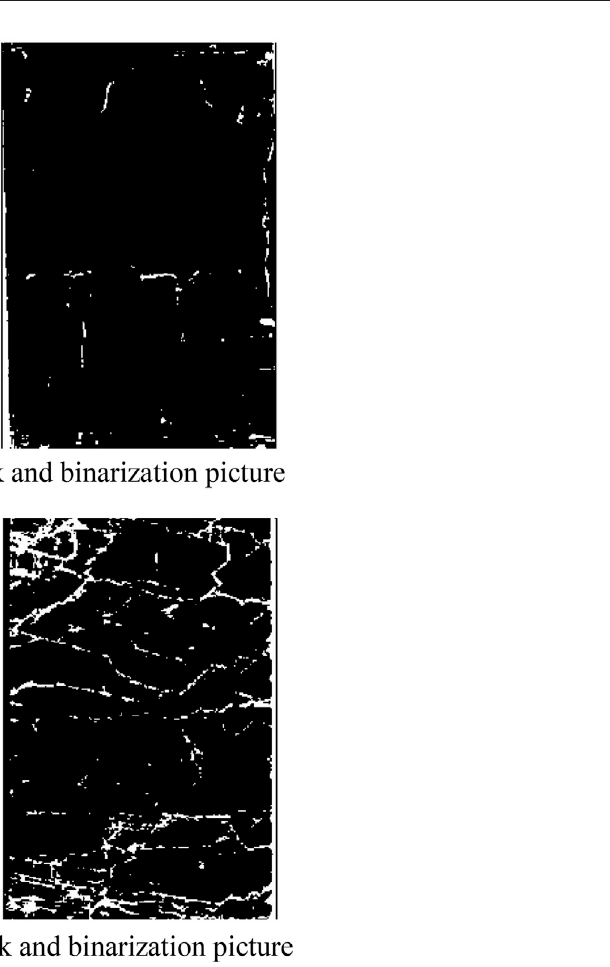
Frontiers in Earth Science |